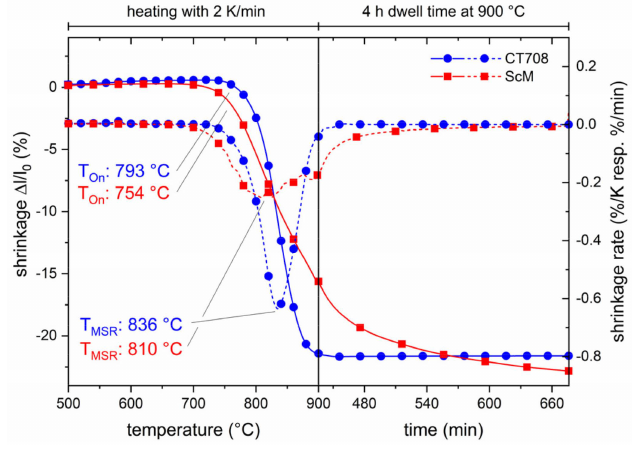
Figure 7. Shrinkage curves of CT708 and ScM ferrite green tapes measured using dilatometry (heating rate 2 K/min, dwell at 900 ◦ C for 4 h).